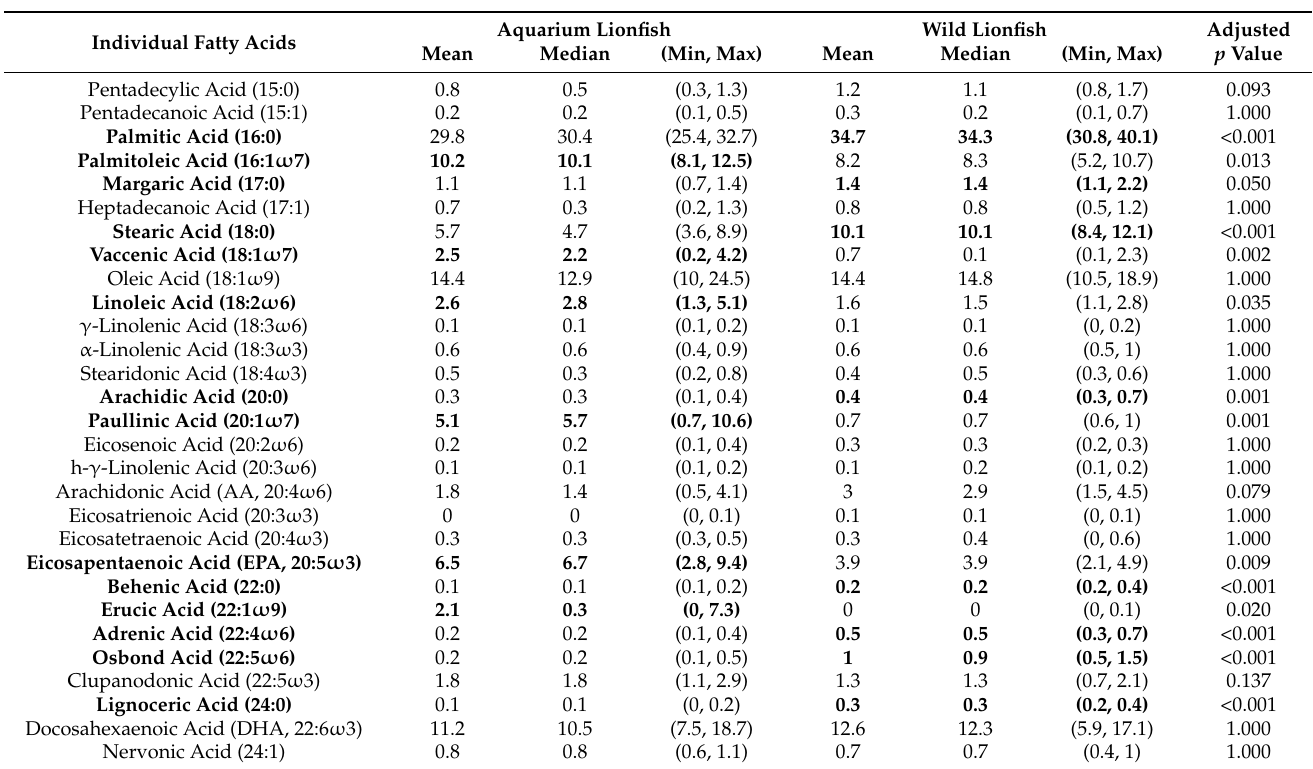
Table 2. Whole blood individual fatty acid profiles of wild, invasive lionfish harvested off the coast of North Carolina and lionfish at the North Carolina Aquariums. Values are provided as a percent of total fatty acids present. To account for multiple comparisons, p values were adjusted using the Bonferroni correction. Fatty acids that significantly differ between wild and aquarium lionfish are in bold , with the higher mean, median, and (min, max) in bold.